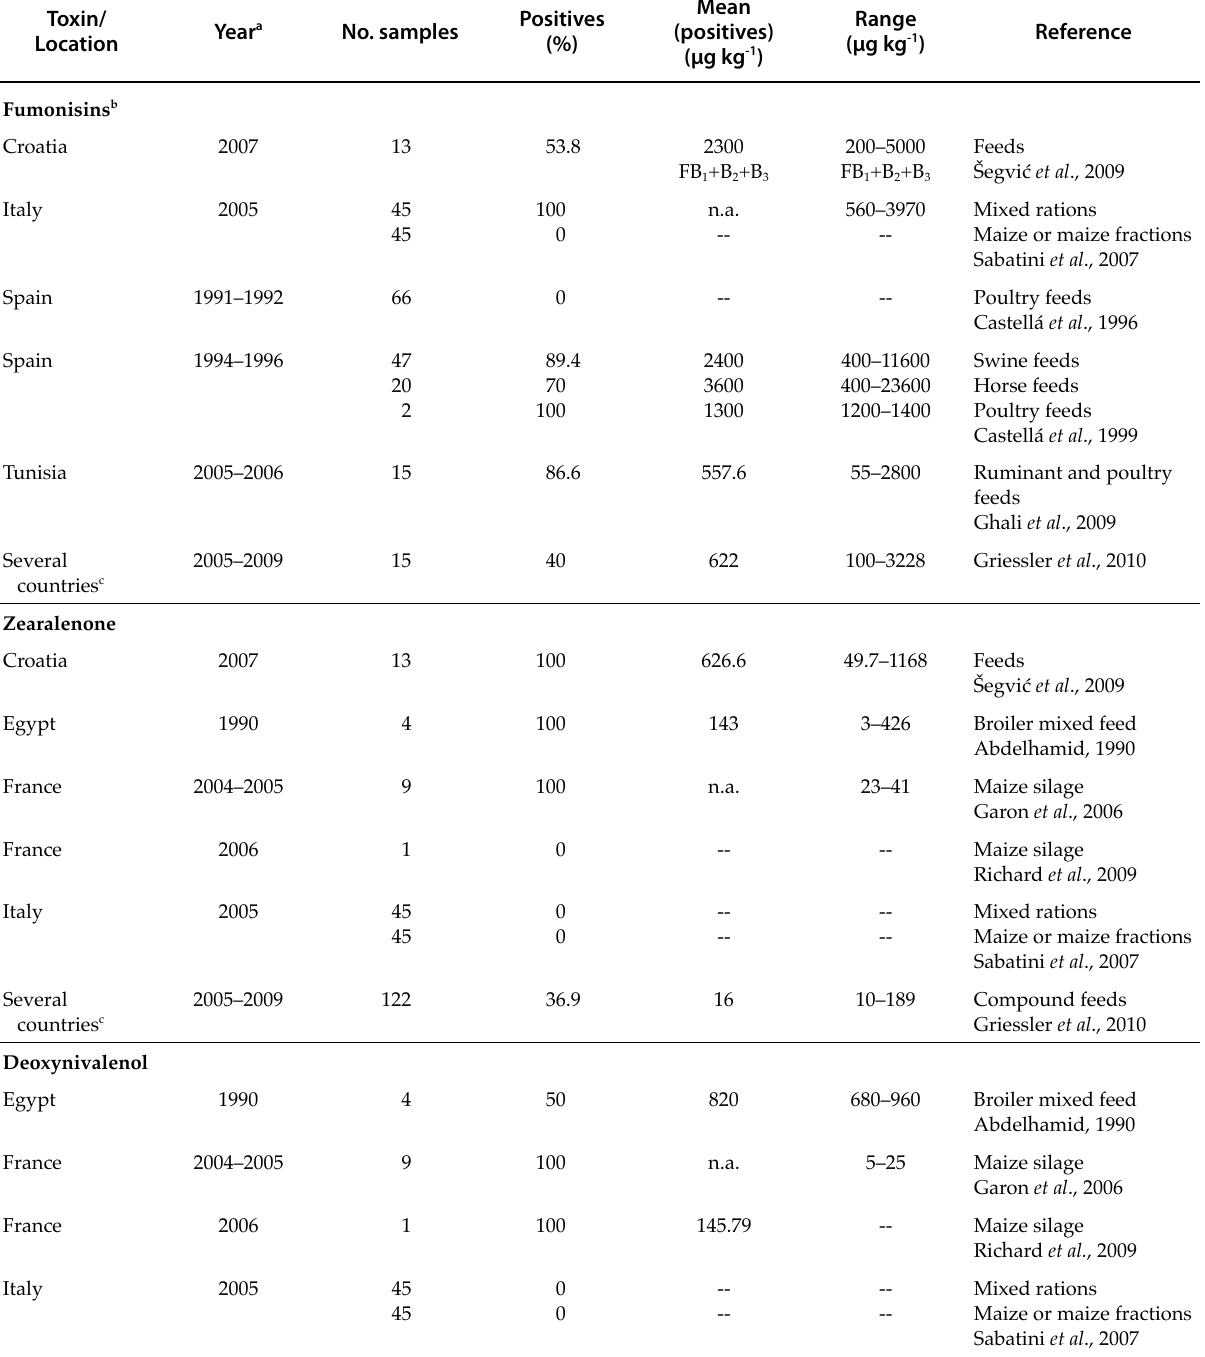
Table 8. Occurrence of Fusarium toxins in maize-based feeds from Mediterranean countries. Toxin/